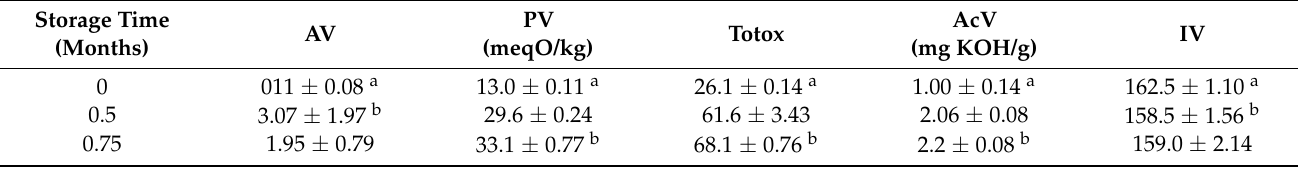
Table 3. Anisidine value (AV), peroxide value (PV) Totox, acid value (AcV) and iodine value (IV) of sage macerate after various storage times at room temperature (22–25 ◦